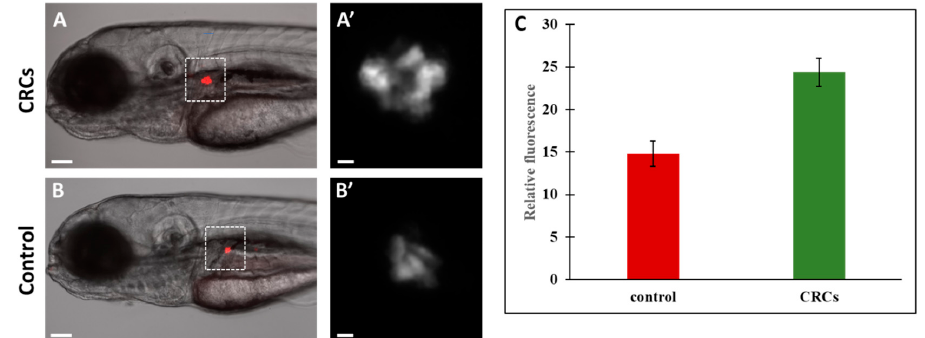
Figure 2. Zebrafish pancreas monitoring after treatment with CRCs. Transgenic zebrafish Tg( ins:DsRed ) were treated at 72hpf with 0.2 mg/mL CRCs for 48h and visualized under fluorescent microscope. There was significant increase of fluorescence on the pancreatic islets of CRCs-treated embryos ( A , A ′ ) compared to the control group ( B , B ′ ). A’ and B’ are micrographs of A and B , respectively. ( C ) fluorescence intensity was quantified using Fiji software. Results shown are the mean +/ − SEM. p < 0.01. Scale bars: A and B: 100 μ m, A’ and B’:10 μ m.